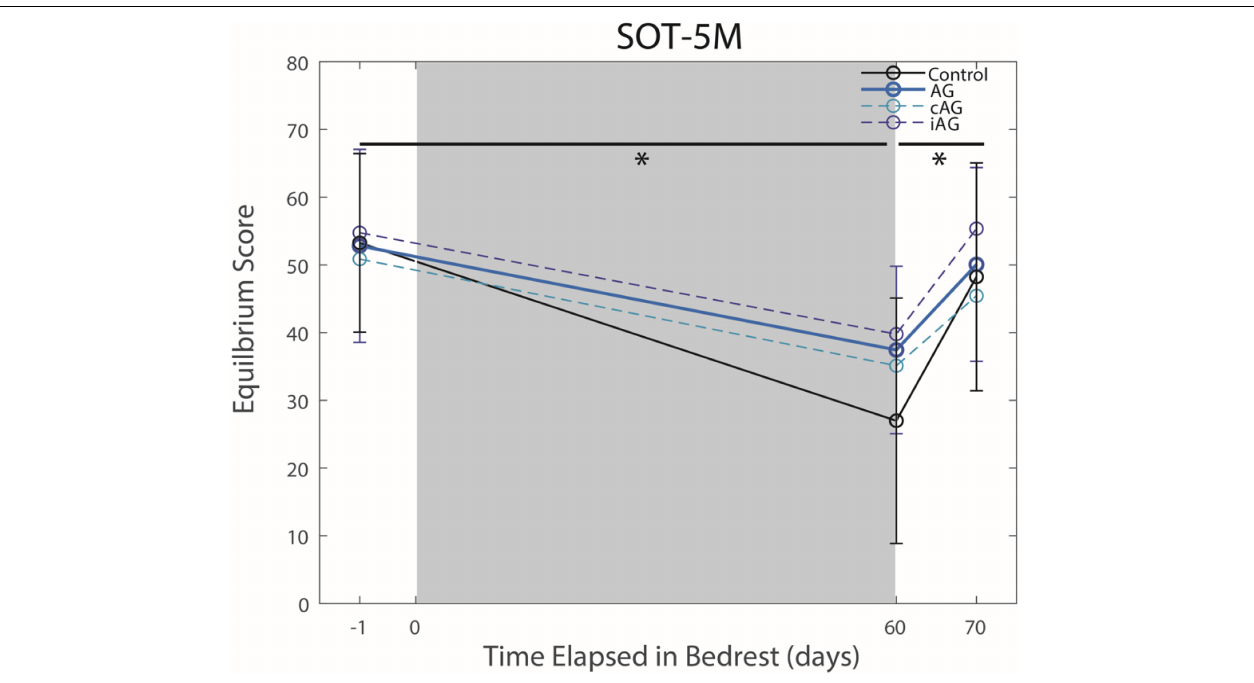
FIGURE 3 | Balance (SOT-5M) changes from pre-HDBR to post-HDBR and post-HDBR recovery. The Sensory Organization Task 5 with head movements (SOT-5M) performance changes in Equilibrium Score indicate an effect of HDBR on balance performance for all groups regardless of AG ( p = 0.0002). There was a significant recovery of performance post-HDBR ( p = 0.043). Significant differences are noted by